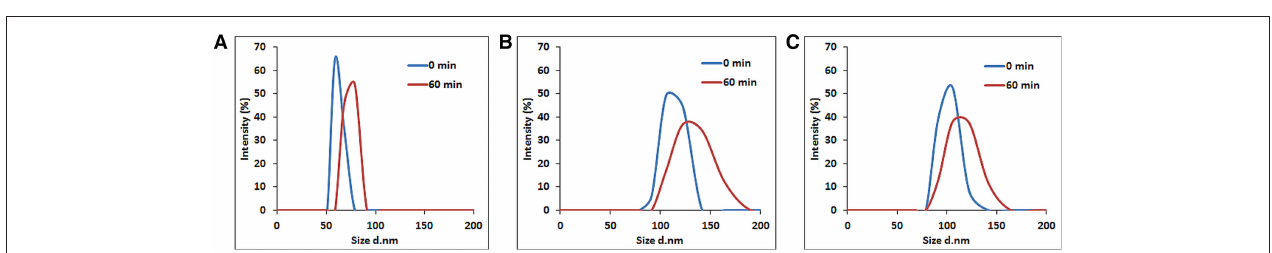
FIGURE 3 | Size distribution of (A) hBNs_boric acid, (B) hBNs_colemanite, and (C) hBNs_boron trioxide.